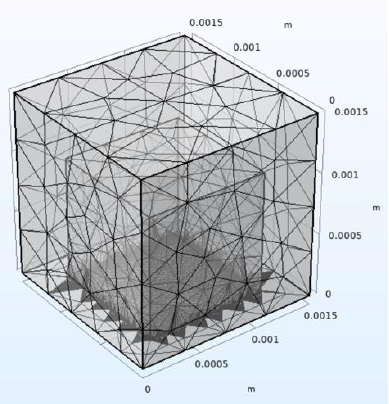
Figure 18. Mesh built in a simulation tool.